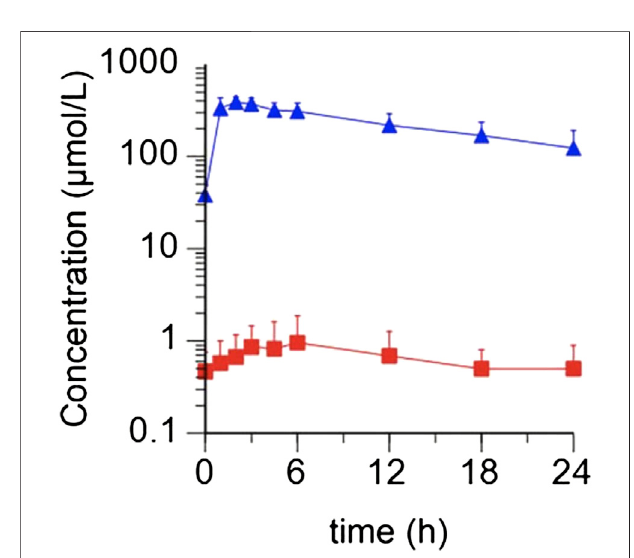
FIGURE2| AverageconcentrationsofplasmaNO 3- and NO 2- observed inpatients( N =5)followinga10 mmoldoseofKNO 3 .NO 3- concentrationsare depicted as blue triangles, and NO 2- concentrations as red squares (Reproduced with permission from Pharmacology Research ).